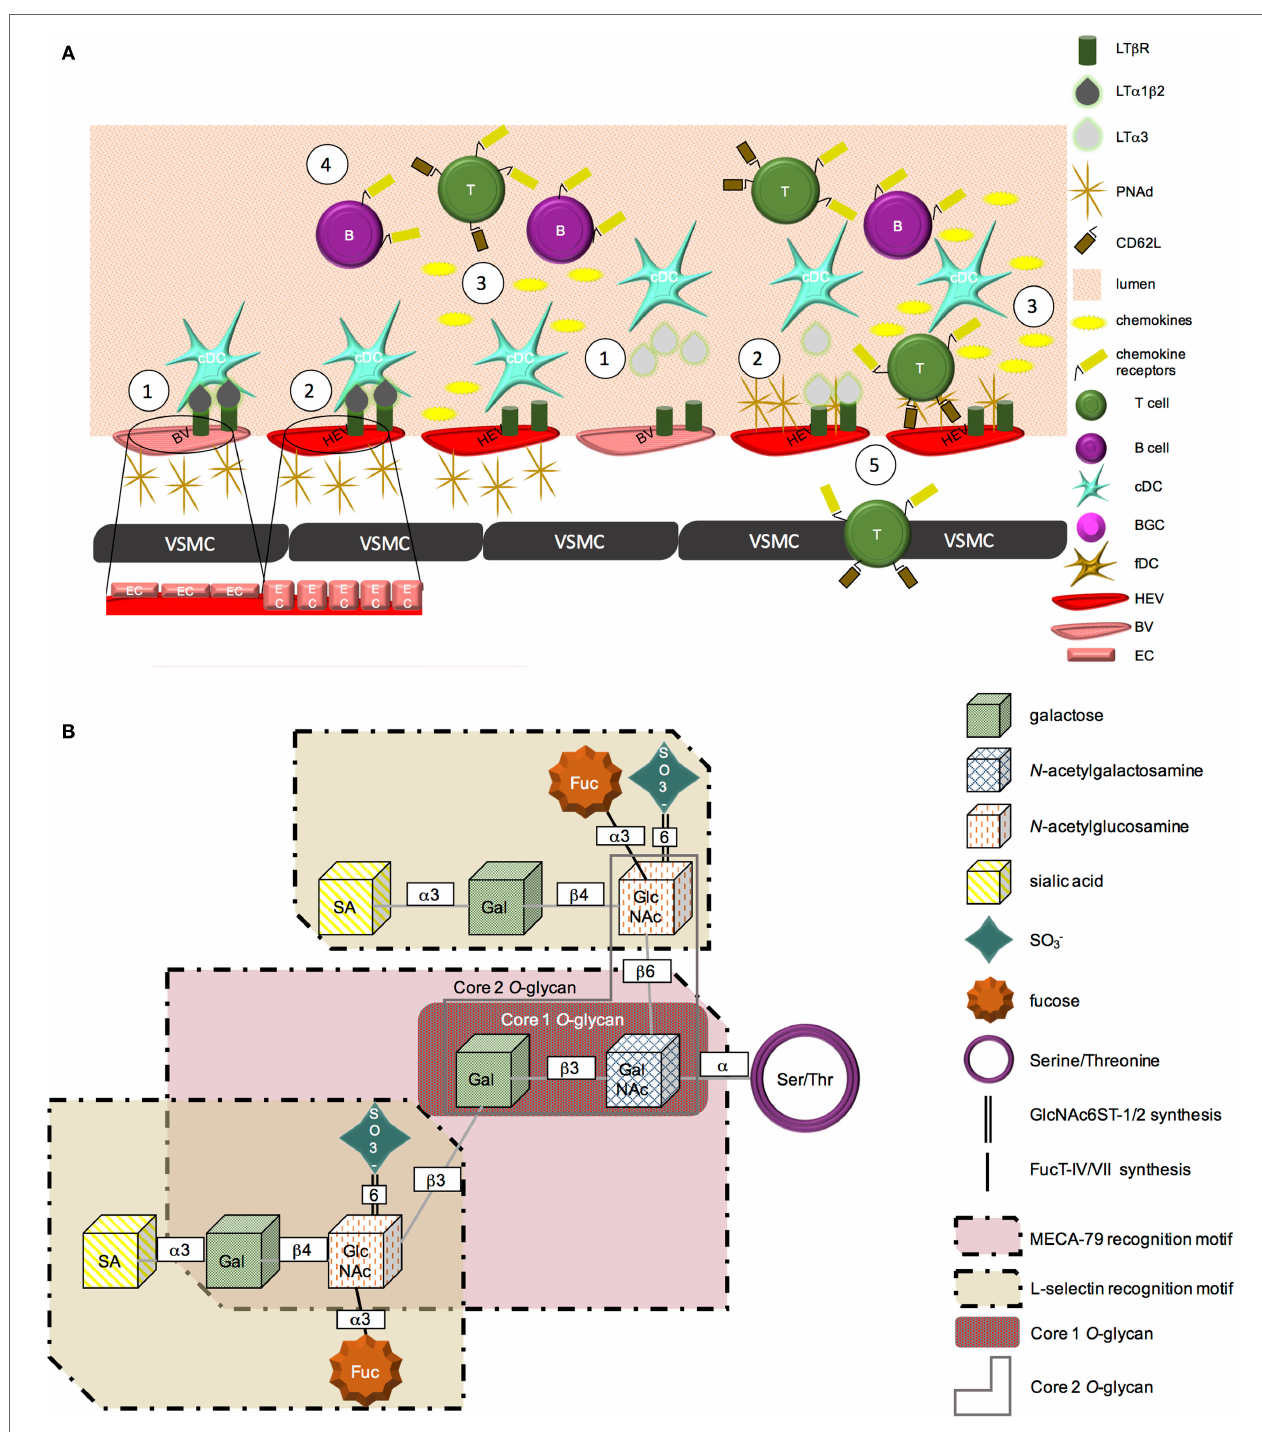
FiGURe 1 | PnAd biosynthesis . (A) (1) LT β R is expressed on blood vessel endothelial cells. Membrane-bound LT α 1 β 2 or secreted LT α 3 secreted from cDC can signal through this receptor. (2) LT β R-mediated signaling promotes a physical change in vascular endothelial cells from a flat to cuboidal morphology. This signaling cascade also leads to the expression of PNAd on the surface of vascular endothelial cells, promoting HEV status. (3) LT β R signaling further induces HEV secreted chemokines, including CCL19, CCL21, and CXCL13. (4) Chemokines form gradients and “decorate” the blood vessel wall, initiating the recruitment of CCR7 + T cells or CXCR5 + B lymphocytes from the peripheral blood circulation into chronically inflamed tissues. (5) L-selectin on the surface of T cells is able to bind PNAd on the surface of HEV. These cells are then able to adhere to the vessel wall and extravasate into the tissue. (B) PNAd is synthesized from a Core 1 O -glycan. The extended Core 1 O -glycan serves as the MECA-79 recognition motif. The fucosylated Core 2 O -glycans are able to be recognized by L-selectin. Sulfation of the extended Core 1 and Core 2 O -glycans at the sixth position is mediated by GlcNAc6ST-1 and -2; α 3 fucosylation is added by FucT-IV and -VII.